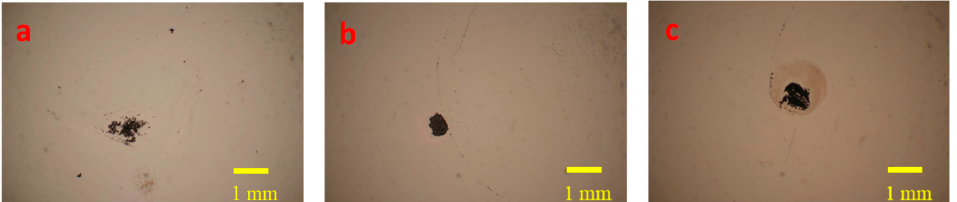
Figure A1. Photographic image showing dried stains of 100 µ L water droplet containing 5 µ m polystyrene microspheres on a glass slide, placed on a hot plate heating device to evaporate the droplet.